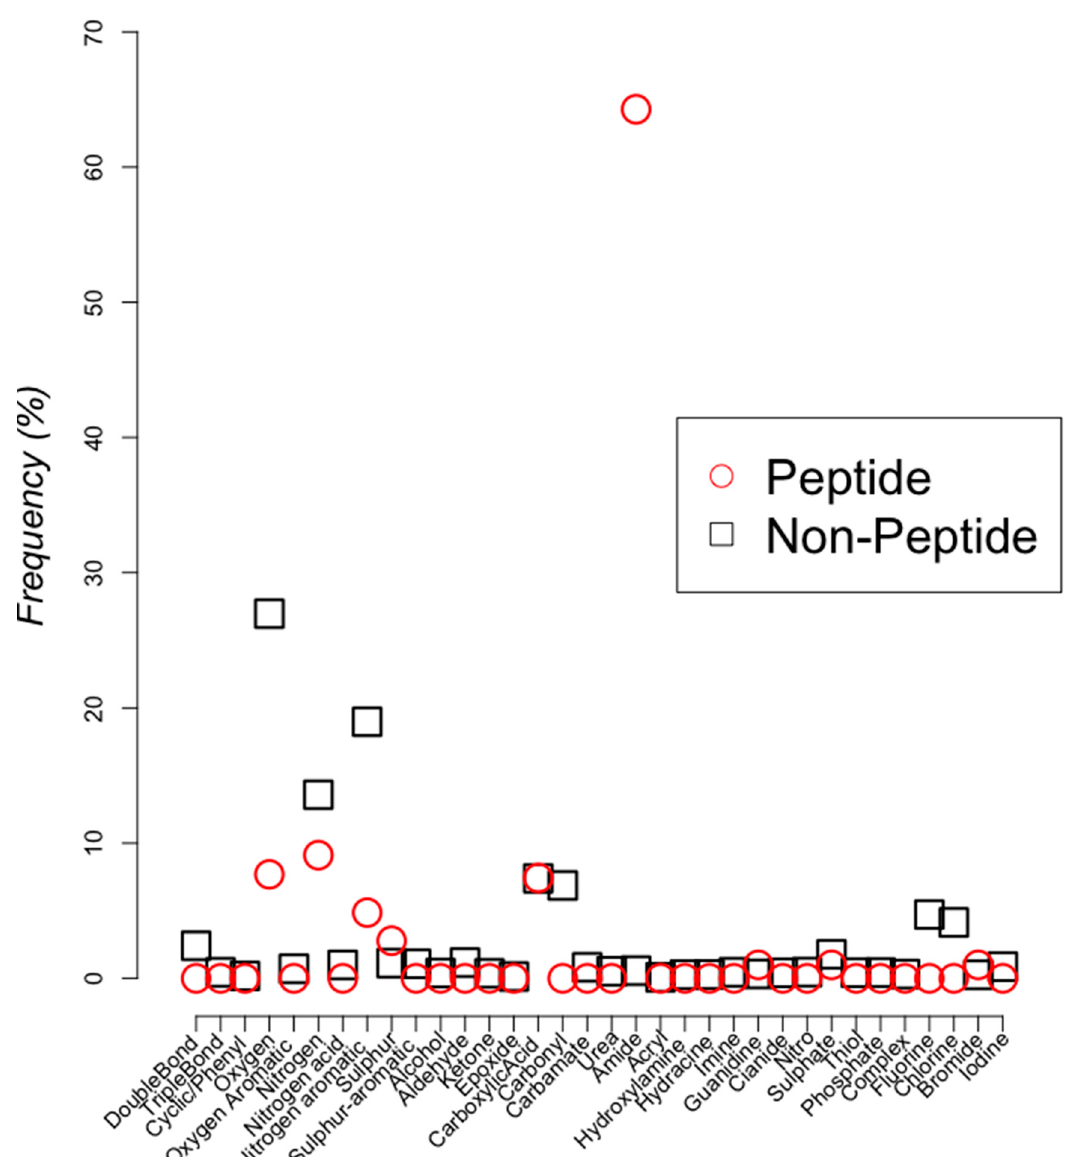
Figure 4. Chemical groups comparison. Functional group frequency (%) is compared between peptides (red circles) with non-peptidic chemical compounds (black squares). The names of the functional groups found in both sets are indicated on the x-axis (see Methods).